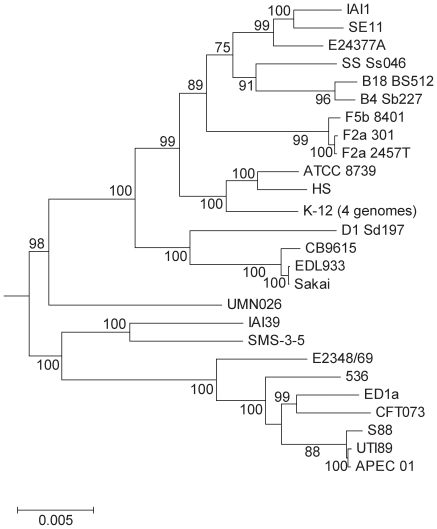
Maximum likelihood phylogenetic tree of 26 Escherichia coli and Shigella strains.The phylogenetic tree of the Escherichia core genome genes was constructed from the concatenated alignments of the 2034 genes in the core genome of the E. coli/Shigella genomes. The closely related species, E. fergusonii (CU928158), was chosen to root the tree.